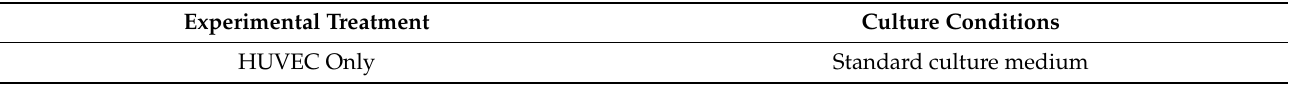
Table 2. Experimental Conditions and Controls for HUVEC Tube Formation